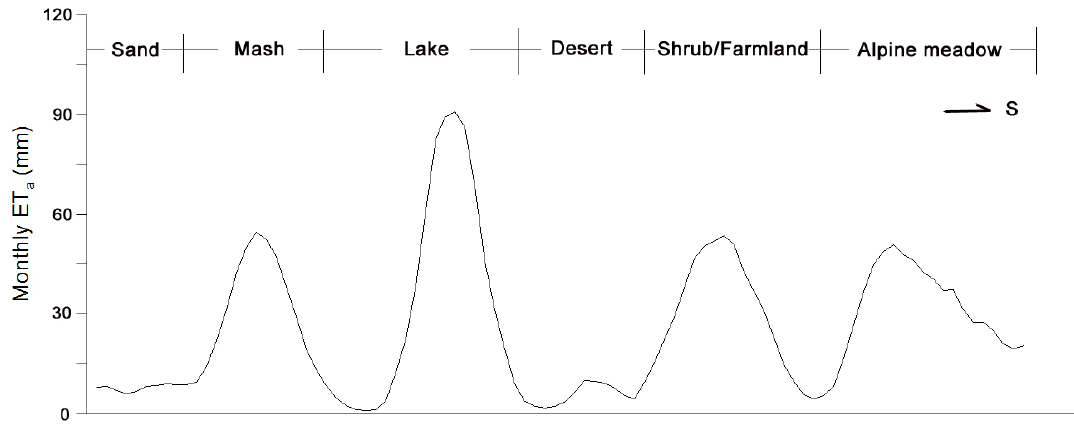
Figure 11. Section of monthly ET